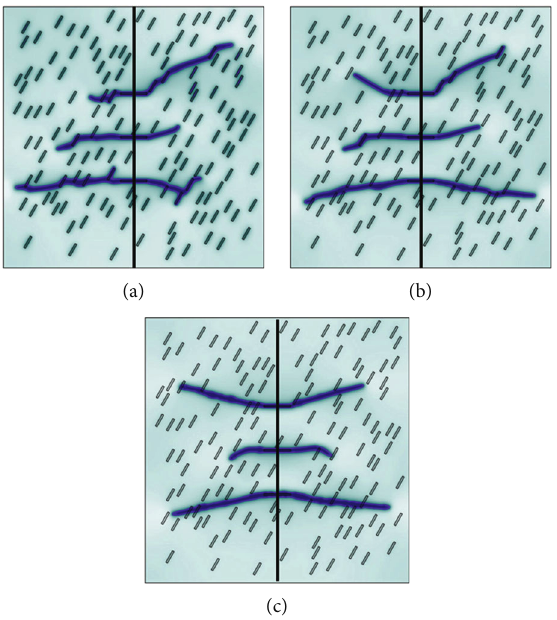
Figure 13: Fracture network morphology for varying fracture energy ratios. (a) η = 0 : 08 , (b) η = 0 : 16 , and (c) η = 0 : 32